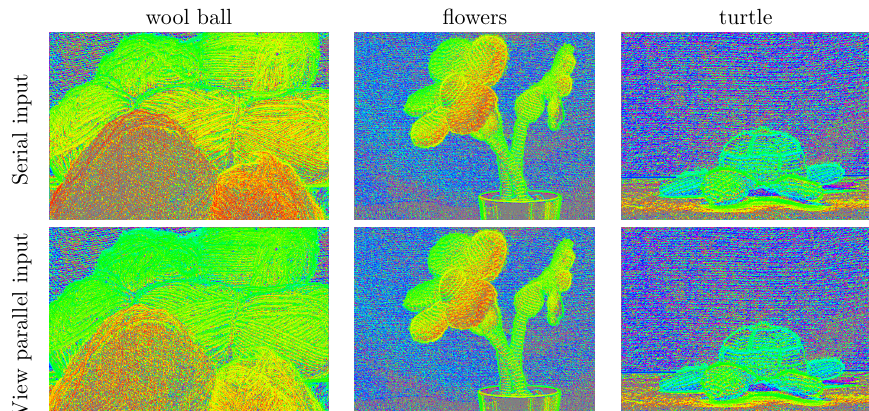
Figure 14. Disparity maps obtained with real light-field data. Row 1: Results with serial input hardware. Row 2: Results with parallel input hardware. Warm colours are objects close to camera while cold colours are objects far from camera. Gray pixels are positions where the algorithm did not provide a valid